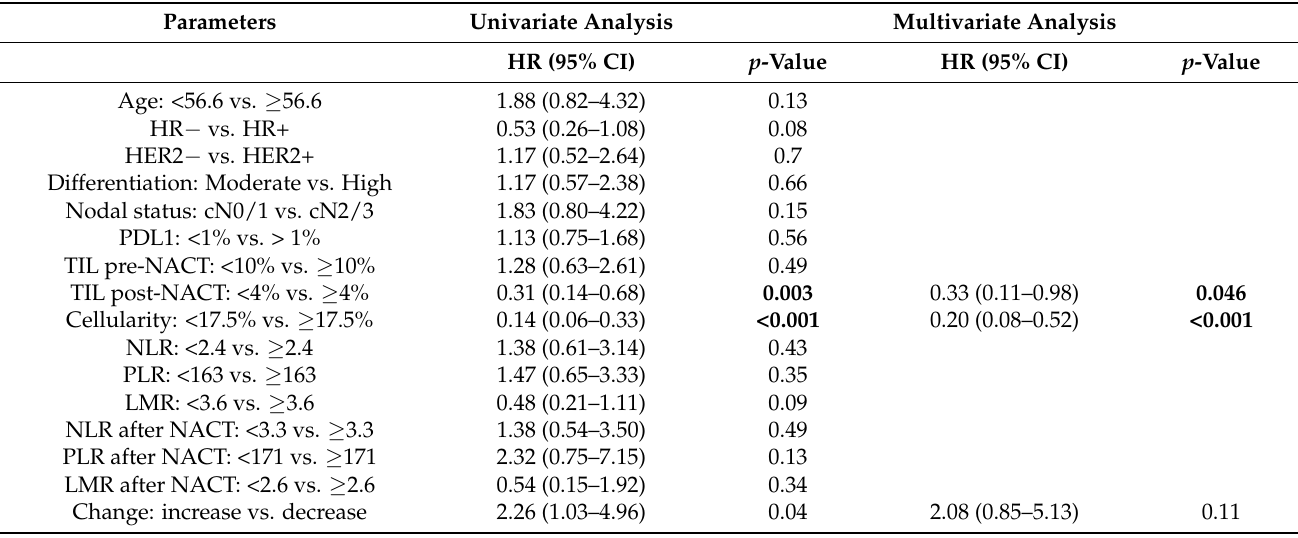
Table 7. Uni- and multivariate analysis for DFS in the group of IBC patients without pCR after NACT. IBC: inflamma- tory breast cancer, HR: hormone receptor status, sTIL: stromal tumour infiltrating lymphocytes, NACT: neo-adjuvant chemotherapy, NLR: neutrophil-lymphocyte ratio, PLR: platelet-lymphocyte ratio and LMR: lymphocyte-monocyte